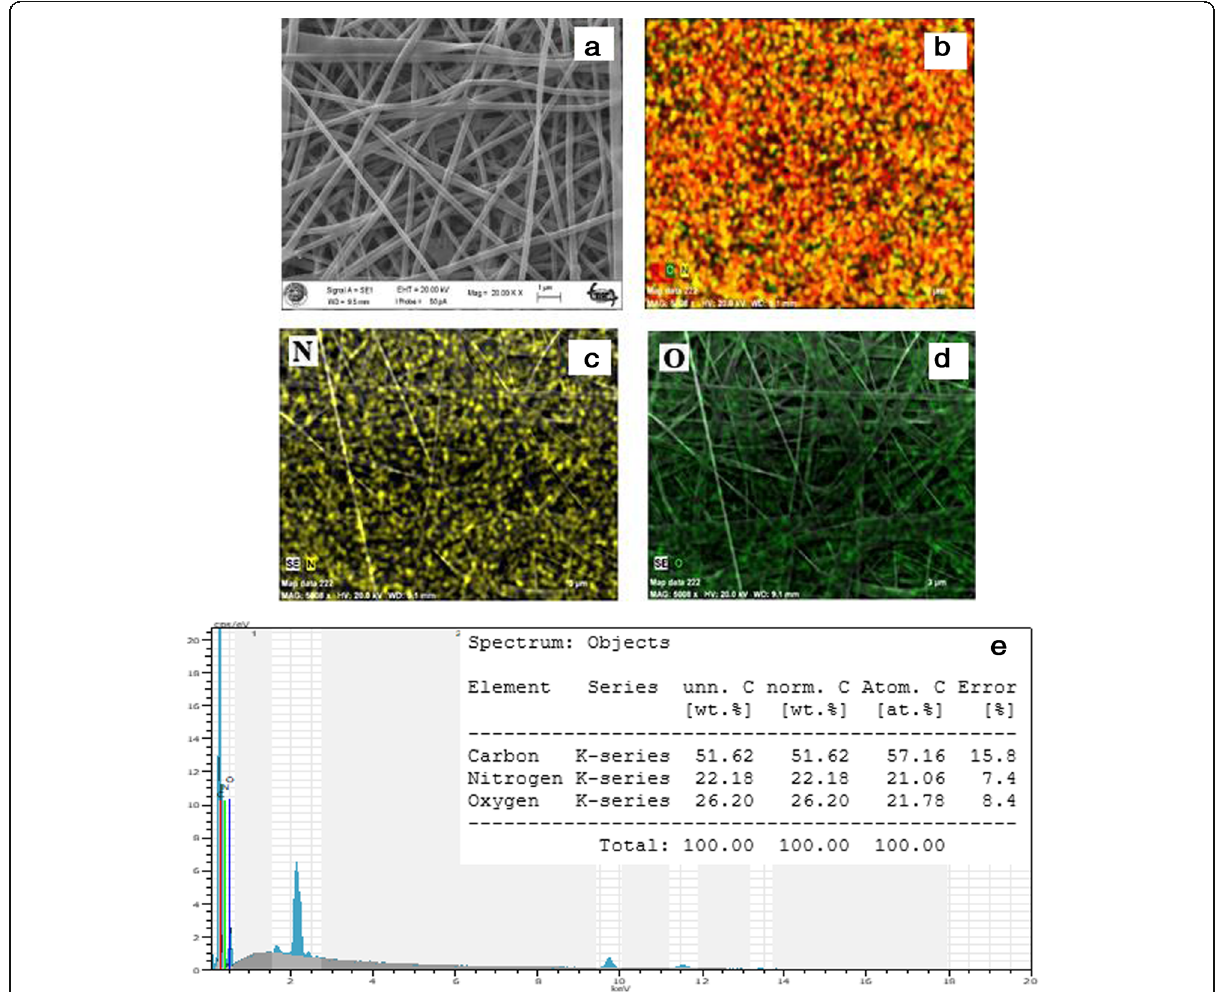
Fig. 5 SEM image of N6,6/GO nanofibers ( a ), EDX elemental maps ( b – d ), and EDX spectrum ( e